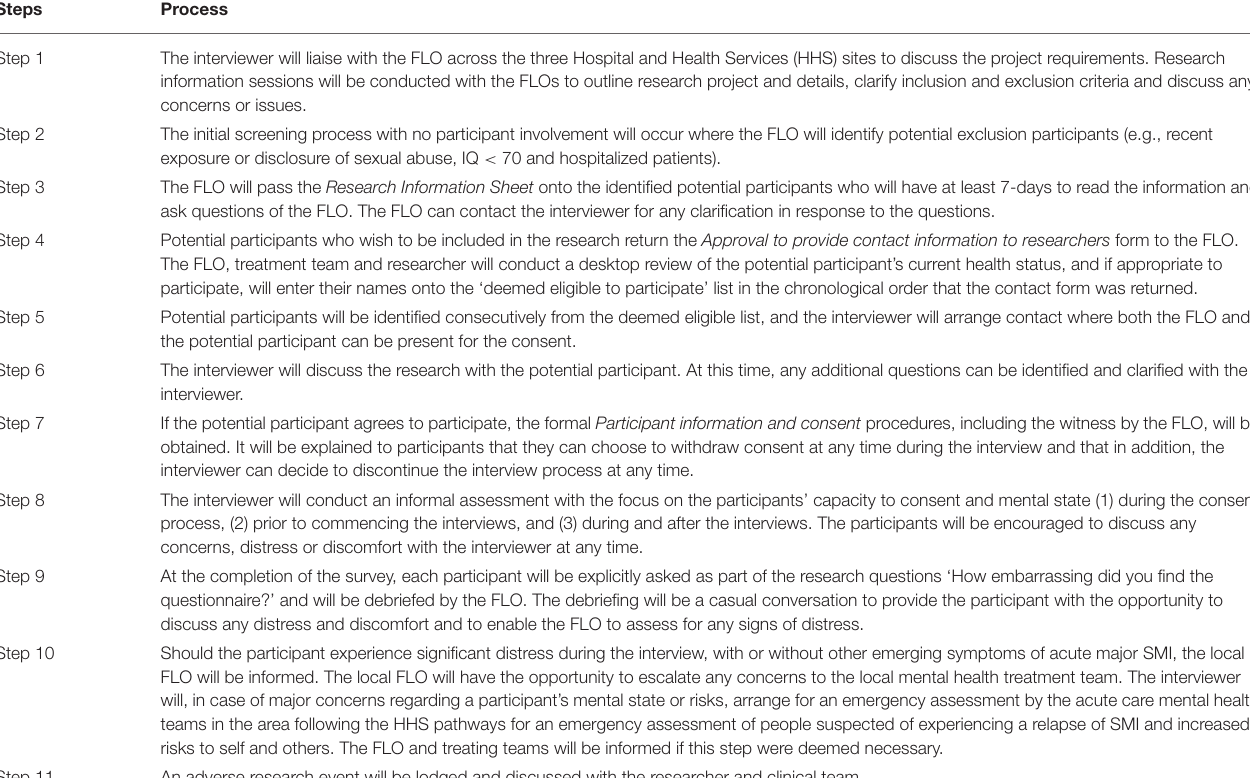
TABLE 2 | Identification, recruitment and consent